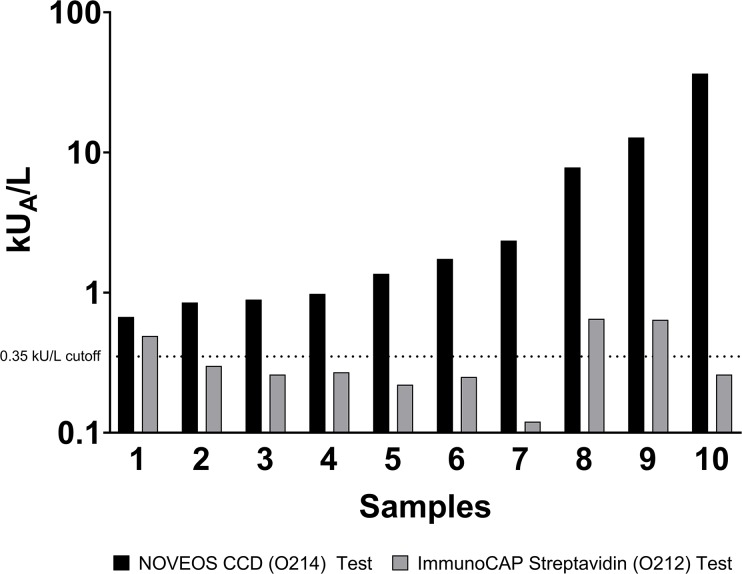
Positive CCD-sIgE patients resulting in false-positive results were tested against ImmunoCAP streptavidin test (O212) with no allergenic proteins present.A single patient was not included due to insufficient volume.